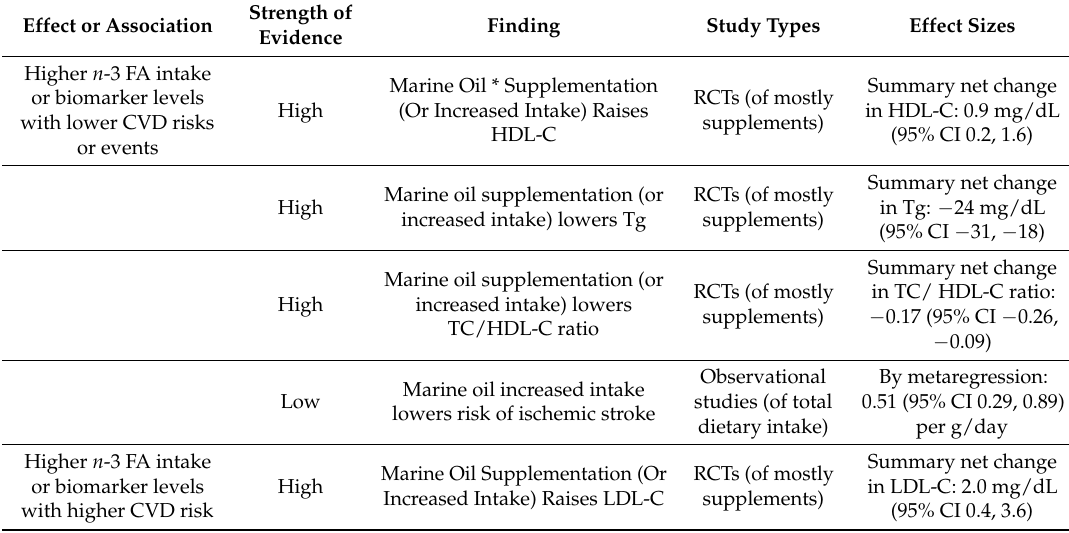
Table 2. Main findings of high, moderate, or low strength of evidence of significant effects or associations between omega-3 fatty acids and